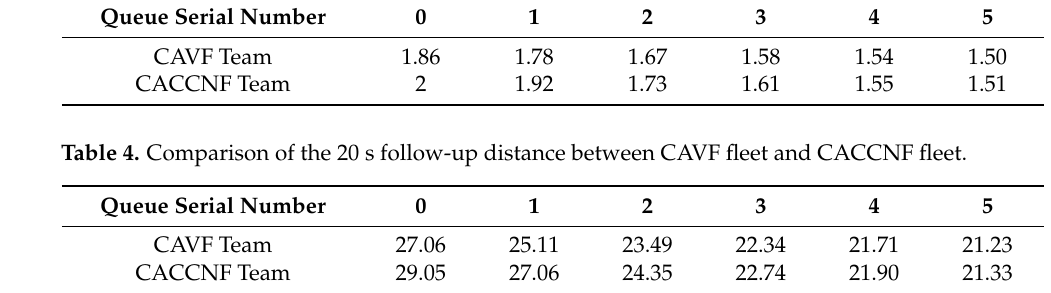
Figure 13. Acceleration thermal diagram of CAVF fleet and CACCNF fleet under scenario 2: ( a ) CAVF fleet acceleration heatmap; ( b ) CACCNF fleet acceleration heatmap. The side lane vehicle cuts into this lane, driving with a positive variable speed and an acceleration higher than the initial speed of the team train. As shown in Figure 14, in the CACCNF fleet, because the side lane vehicle accelerates into this lane and the speed is higher than the speed of the team train, the traffic oscillation changes gradually from the head vehicle to the tail vehicle, and the deceleration process of the head vehicle, as well as the speed change process, is longer, which leads to the back vehicles undergoing real- time speed changes to protect the stability of the vehicle. The time domain of speed change of the CAVF fleet is reduced by 2 s, and the fleet stability is reached more quickly.